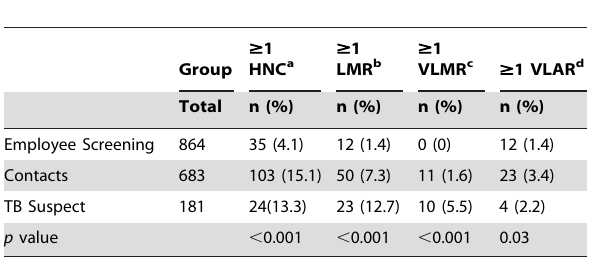
Table 3. Subjects in Each Group with Unusual IFN- c Measurements.